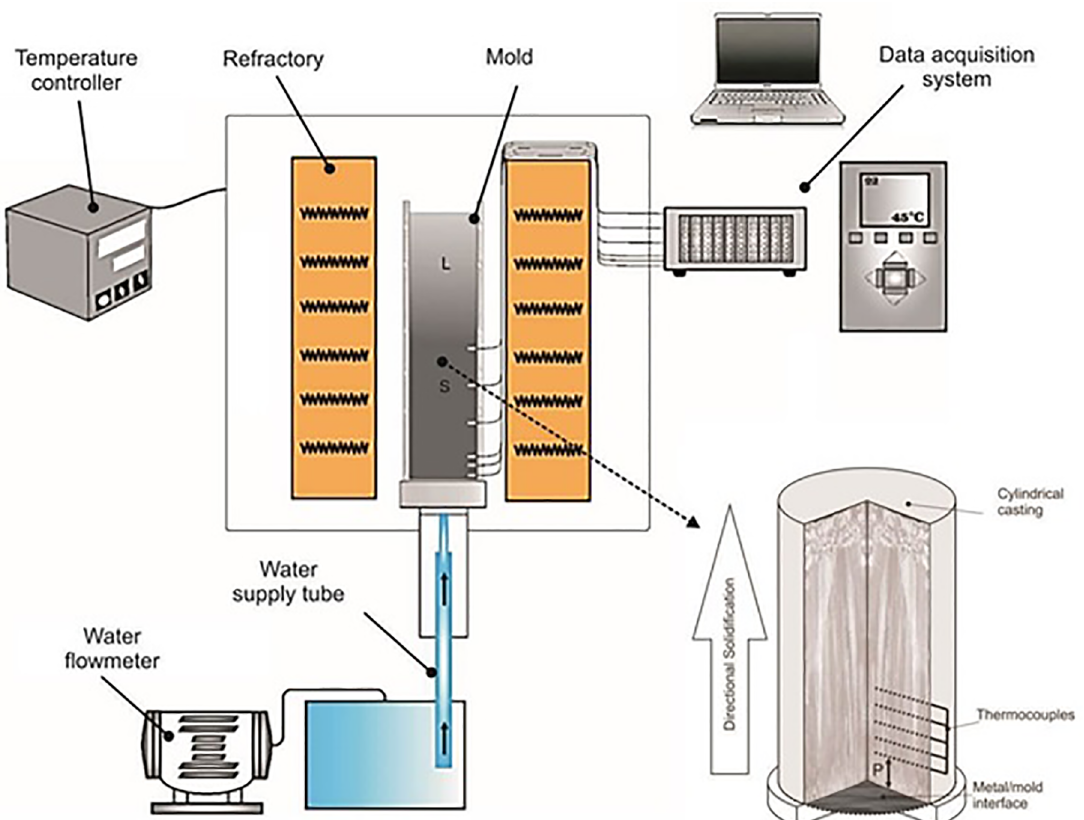
Figure 1. Vertical upward directional solidification casting assembly and connected devices used to produce the directionally solidified Sn-Ni alloys castings